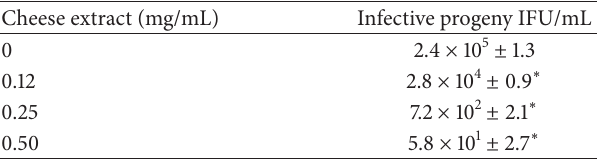
Table 1: HL cells were plated, grown, and infected with C. pneumoniae at MOI 1 . Additions of the Roquefort cheese extract fraction with final concentrations of 0.12, 0.25, and 0.55 mg/mL were performed simultaneously with the bacterial pathogen inoculation. The cell monolayers were harvested after 72 hours incubation at and infective progeny number was determined 35 ∘ C in 5% CO 2 as described in Section 2 . Infective progeny formation in U-937 cells infected with C. pneumoniae in the presence of cheese protein extract. Cheese extract (mg/mL) Infective progeny